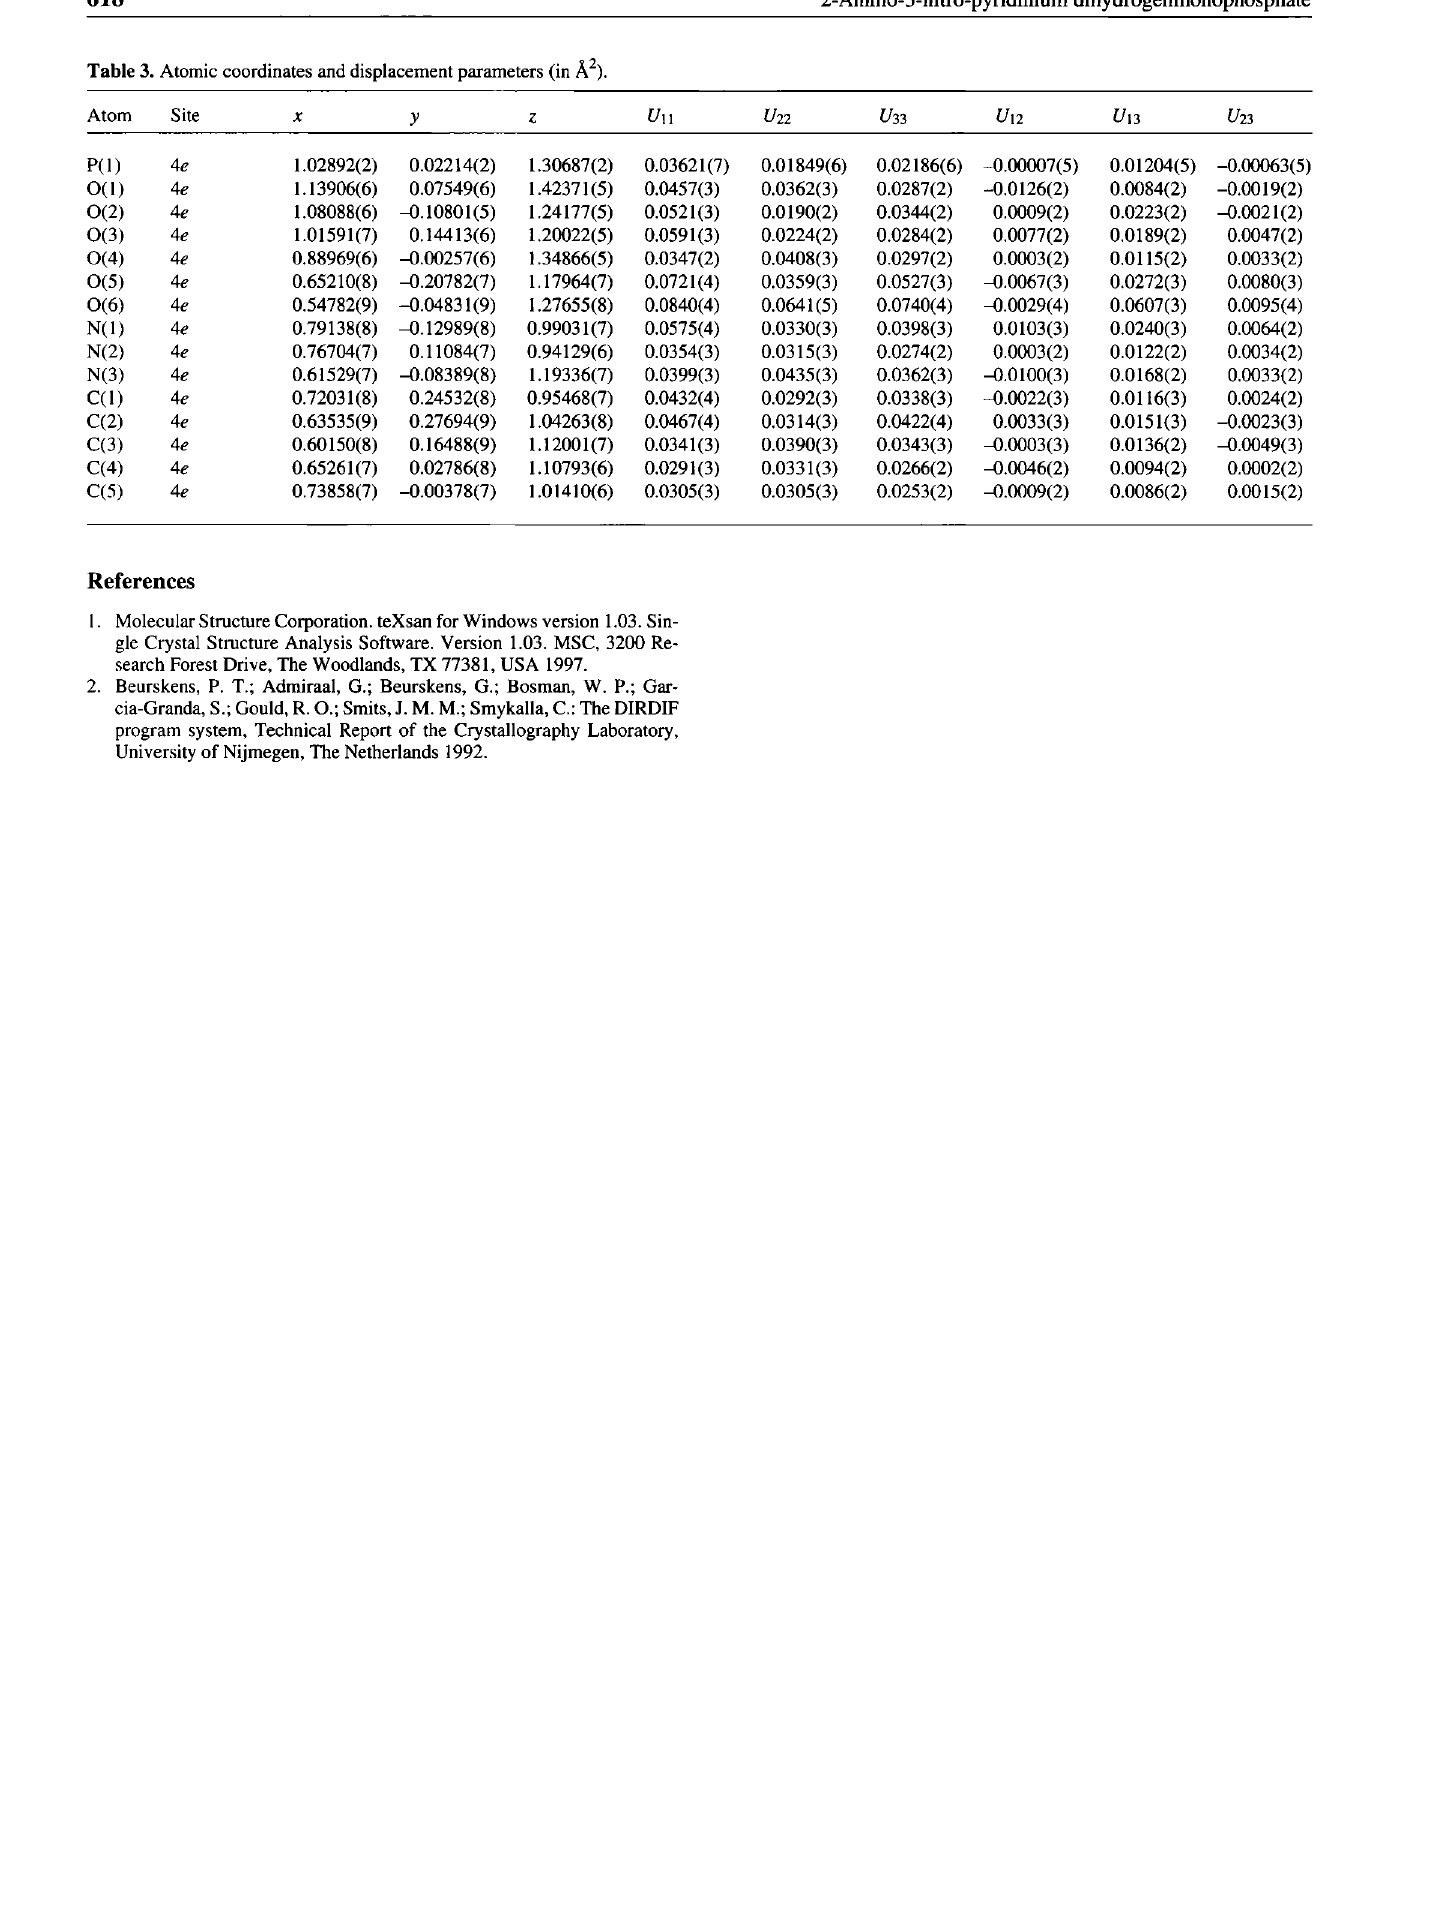
Table 3. Atomic coordinates and displacement parameters (in Â 2